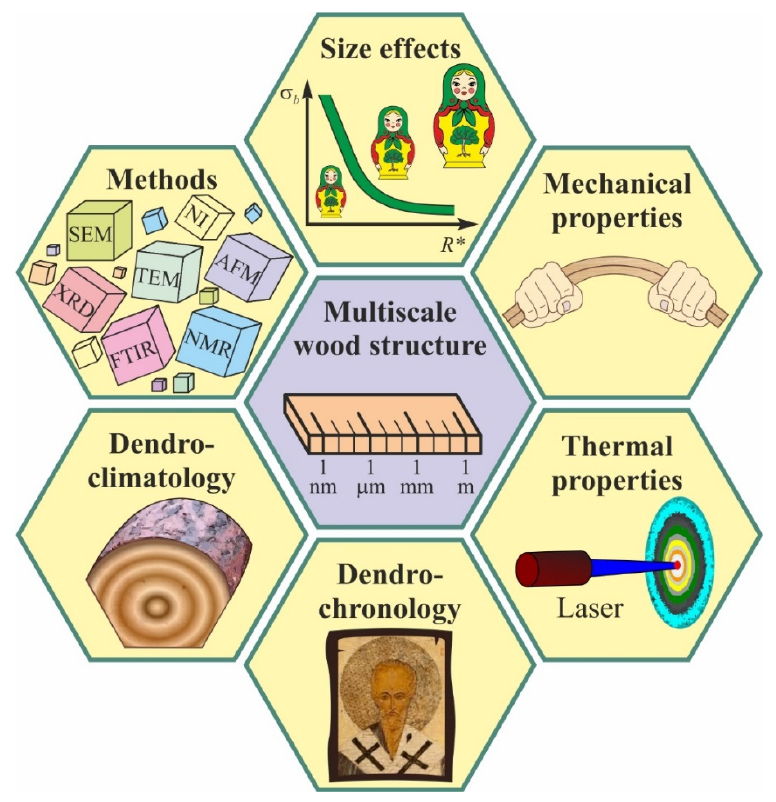
Figure 2. The main scopes of the review.